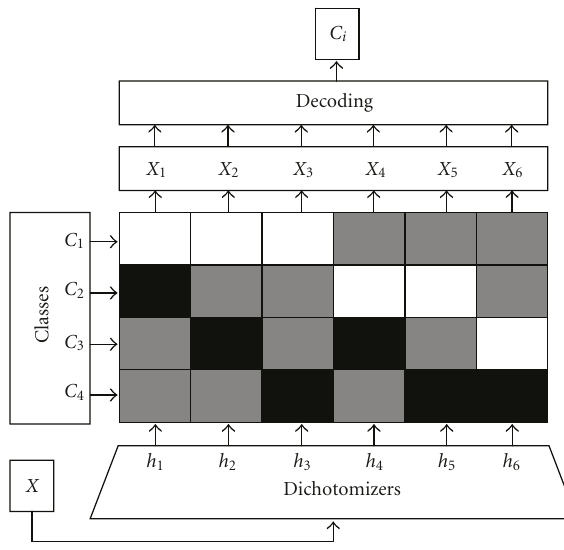
Figure 5: One-versus-one ECOC design for a 4-class problem.